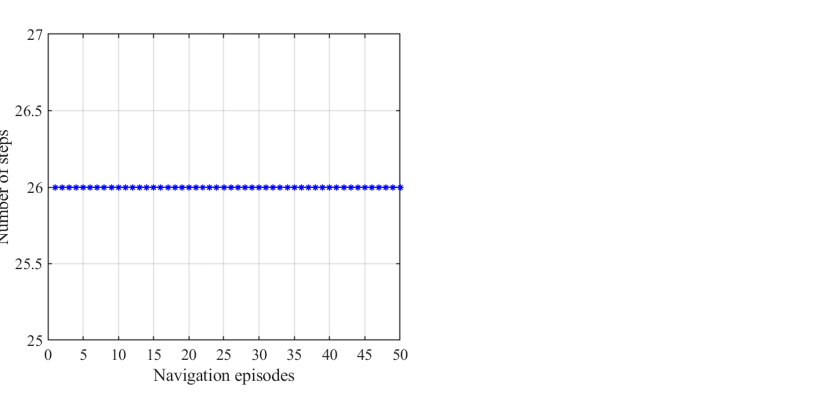
them mark the generated cognitive map. Blue lines represent navigation path.